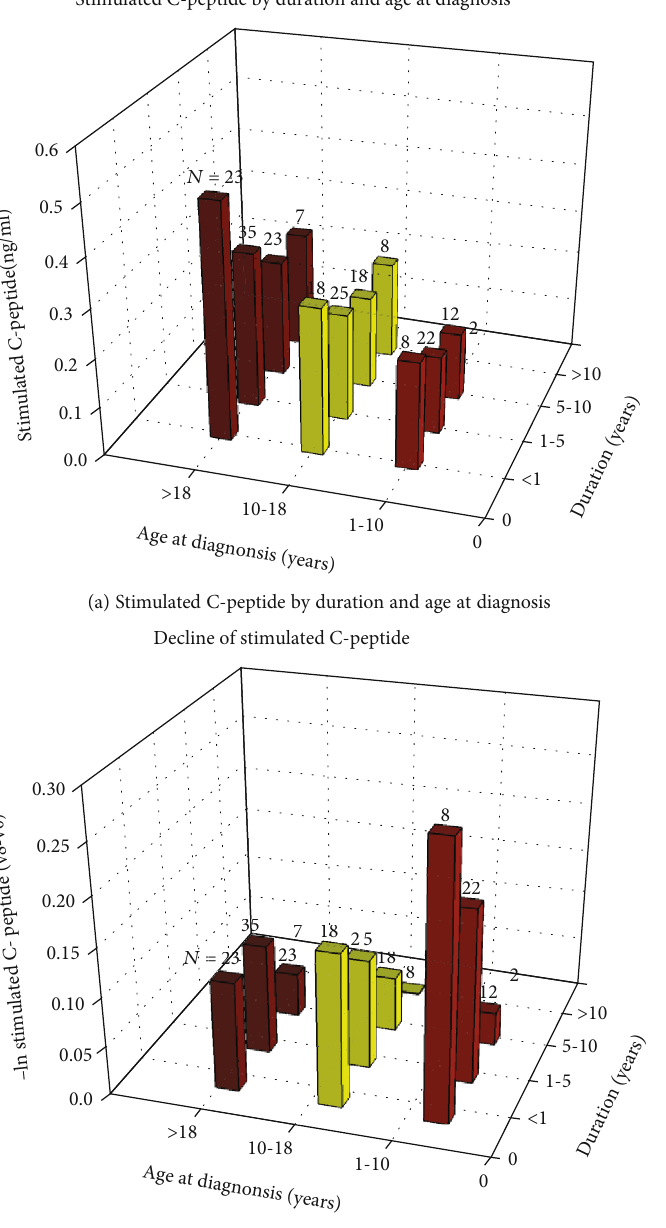
Figure 3: Stimulated C-peptide by duration and age at diagnosis. The associations of age at diagnosis and diabetes duration with stimulated C-peptide were illustrated in (a). Each box represents the mean stimulated C-peptide of the individuals under the corresponding condition of diabetes duration and age of diagnosis. The associations of age at diagnosis and diabetes duration with decline of stimulated C-peptide (v8-v0) were shown in (b). Each box represents the mean decline of stimulated C-peptide (v8-v0) under the corresponding condition of diabetes duration and age of diagnosis. V0: the 0th visit; V8: the 8th